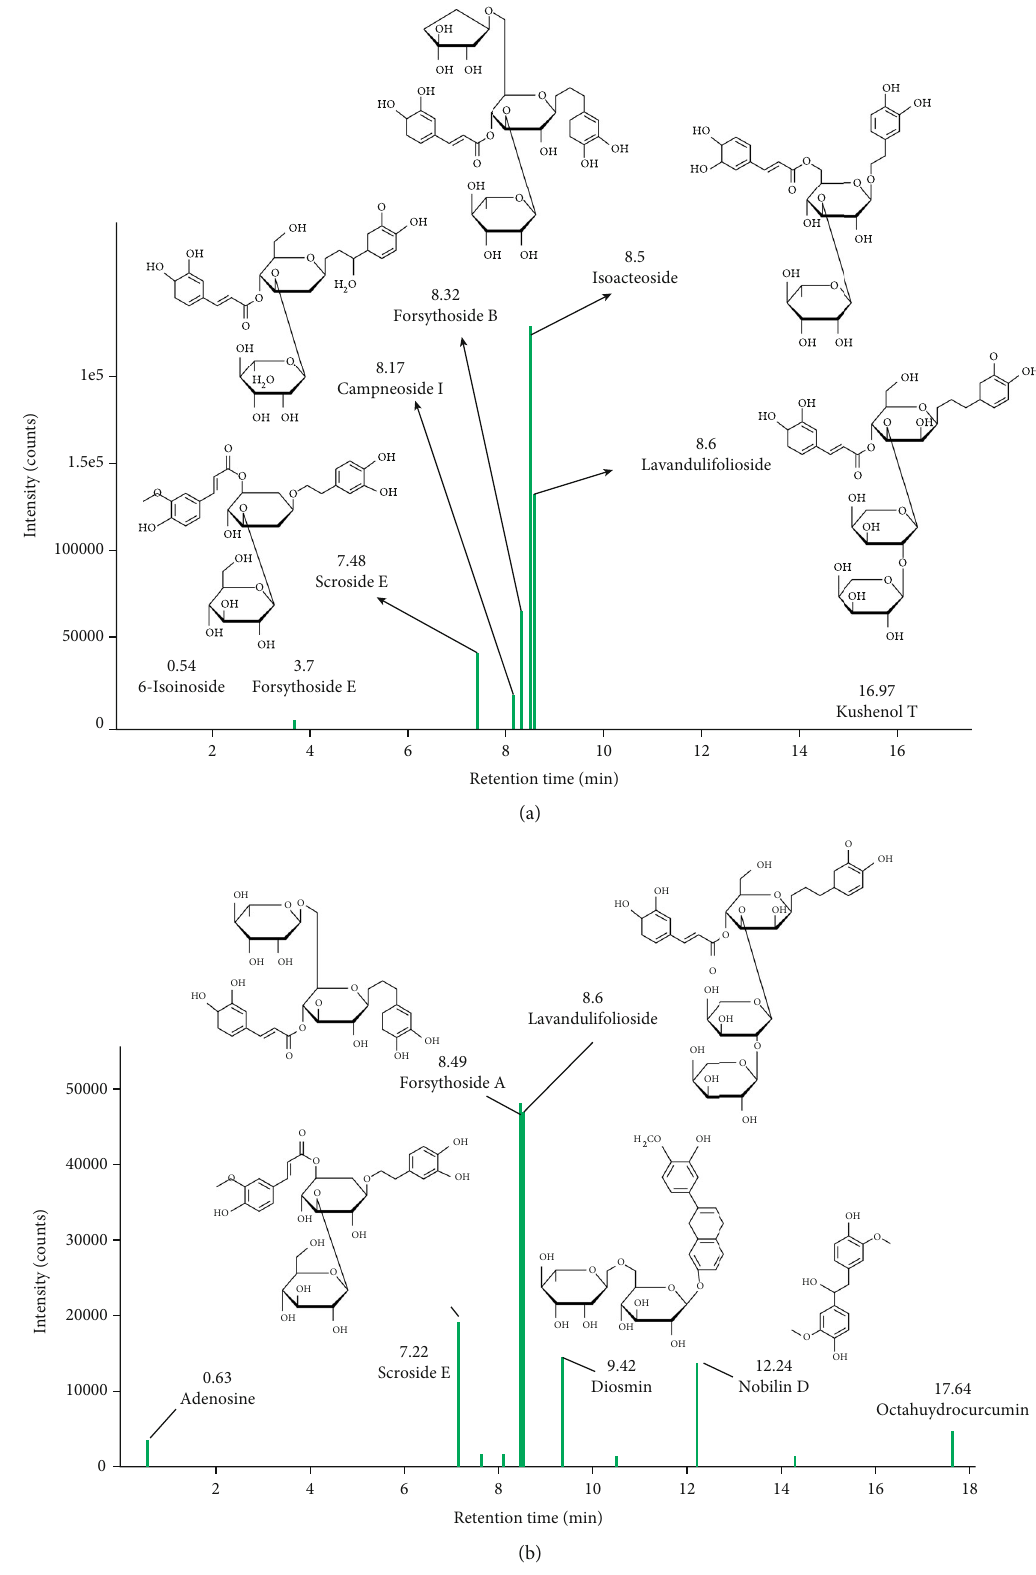
Figure 3: LC-QTOF-MS/MS chromatogram of major compounds identi fi ed in ethanol extract of P. serratifolia leaves using (a) negative and (b) positive